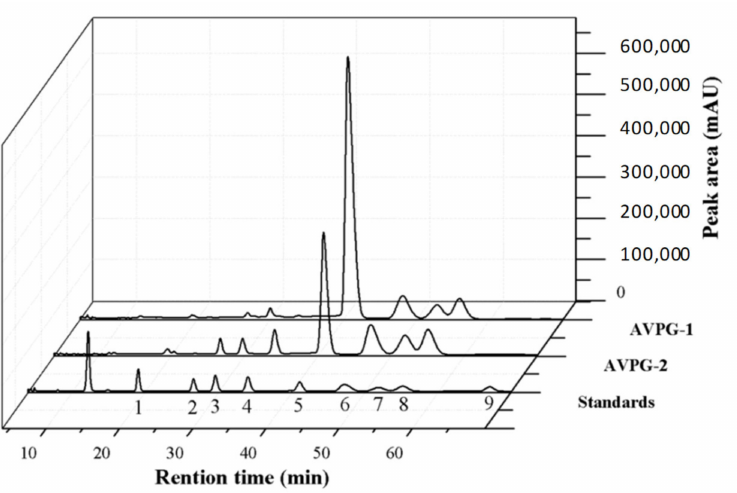
Figure 2. The compositions of AVPG-1, AVPG-2 and nine monosaccharide standards detected by high performance liquid chromatography (HPLC). Peak identity: (1) mannose, (2) rhamnose, (3) glucuronic acid, (4) galacturonic acid, (5) glucose, (6) galactose, (7) xylose, (8) arabinose and (9)